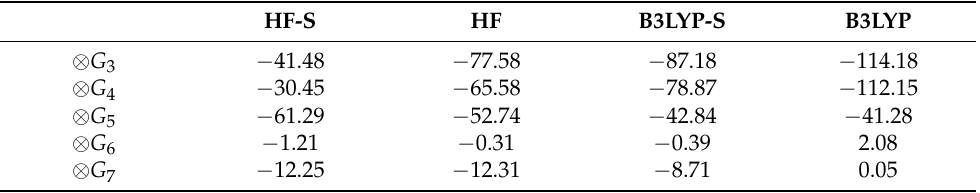
Table 2. Reaction-free energy comparison for various computational methods for the reaction pathways 3–7 in Figure 3.